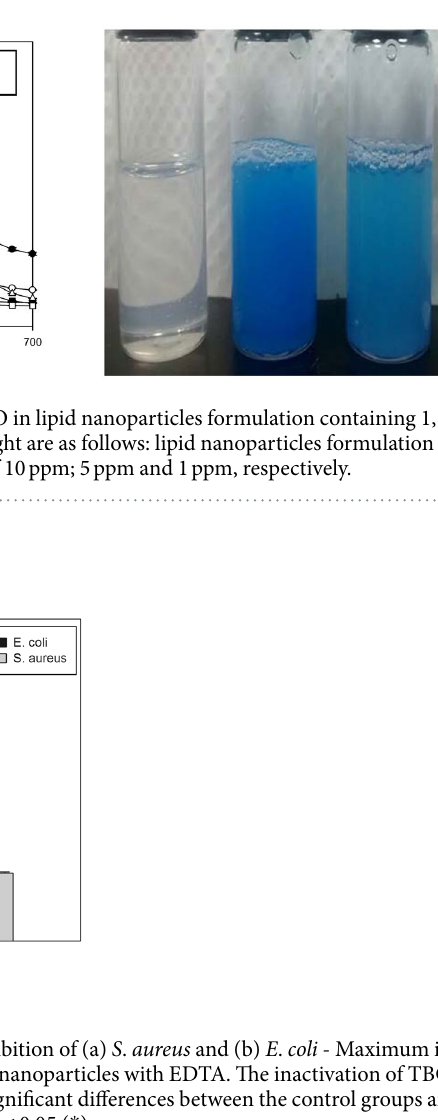
the polydispersity index of the formulation (Fig. S9) was noticed. This proved that the formulation of lipid nan- oparticles was stable in encapsulating TBO over the said duration of two months. In addition, we examined the cell toxicity of different formulations on the suspended Chinese hamster ovary cells. The toxicity to the cells was decreased after the usage of lipid nanoparticles for encapsulating TBO. TBO in aqueous mode posed significant toxicity to the tested cells. TBO encapsulation in lipid nanoparticles somewhat mitigates the toxicity and reduces the toxic effect as indicated in Fig. S10. Factors affecting the efficiency of PAT on bacteria. In the case of both Gram-positive strain S . aureus (Fig. 2, gray bars) and Gram-negative strain E . coli (Fig. 2, black bars), maximum reduction in bacterial popula- tion after PAT was obtained by the formulation combining EDTA with TBO in a lipid nanoparticle delivery sys- tem (~3 logs for S . aureus and ~4 logs for E . coli ). EDTA alone was not able to cause damage to both the bacterial strains (Fig. S3). Also, the lipid nanoparticles alone without TBO were not able to exert significant inhibitory